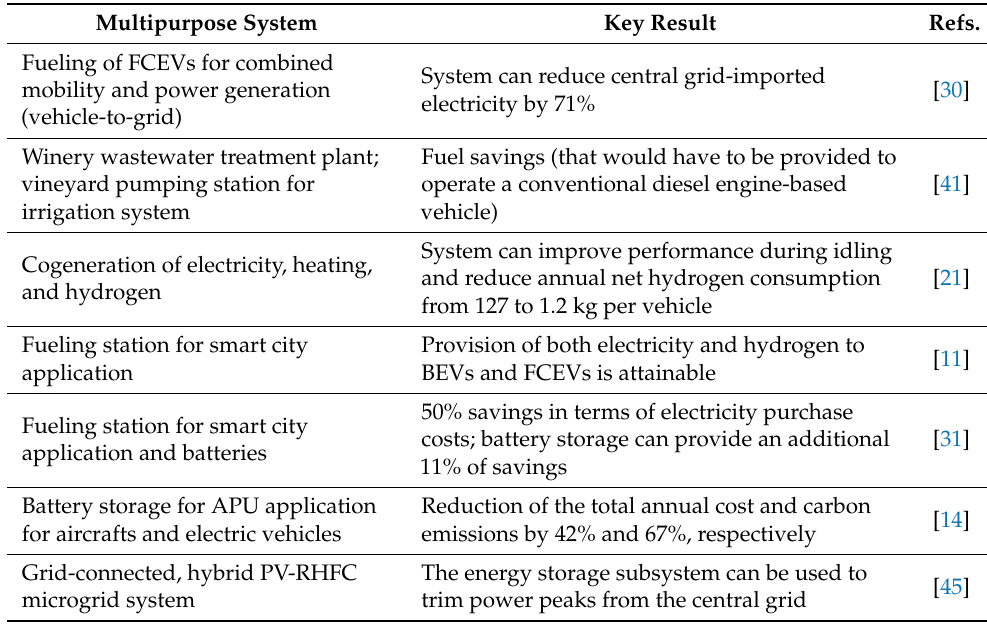
Table 4. Multipurpose microgrid system